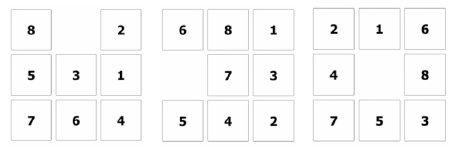
Figure 3 . Three starting